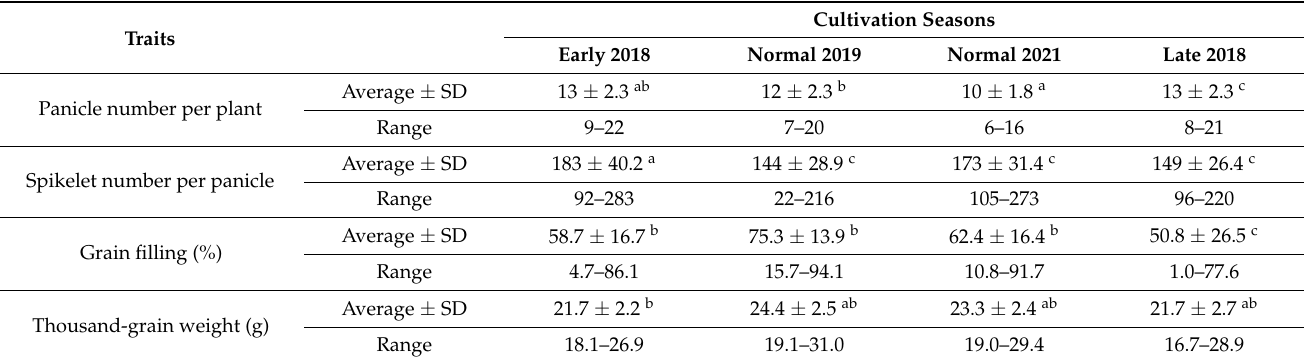
Table 1. Grain properties of parental lines (93-11 and Milyang352) in di ff erent cropping seasons (*: